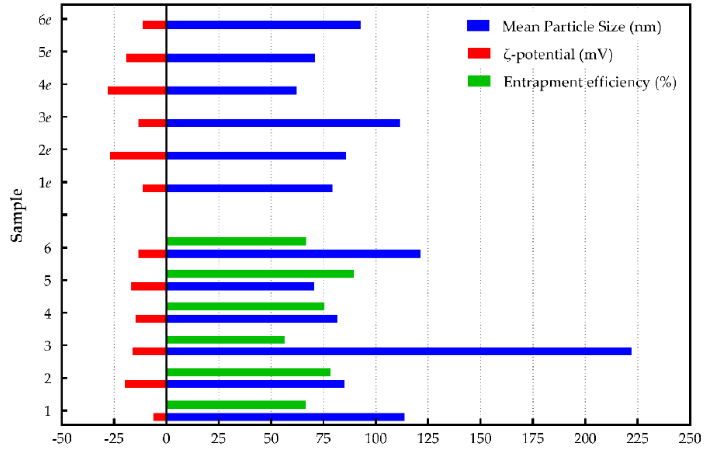
Figure 2. Comparison of liposomal formulations.